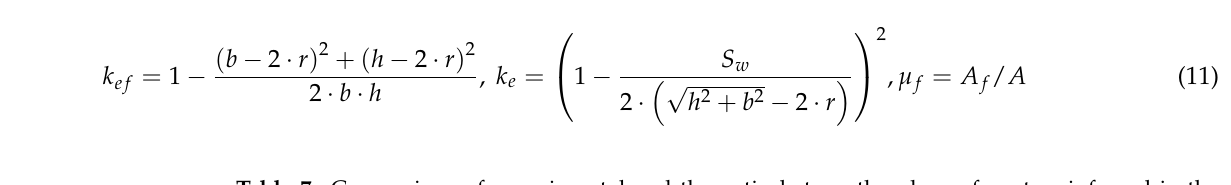
Table 7. Comparison of experimental and theoretical strength values of posts reinforced in the transverse direction with composite materials, considering the proposed coefficients k f1 and k f2